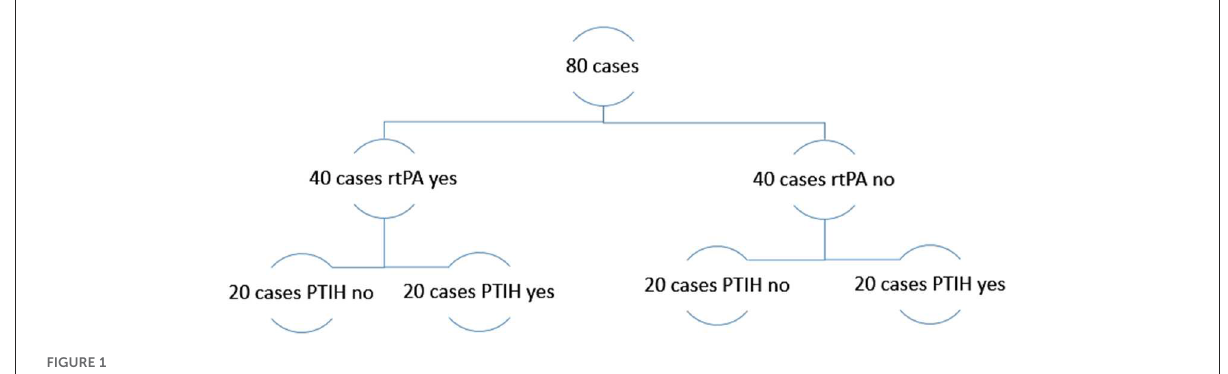
FIGURE1 Experimental plan of the study.